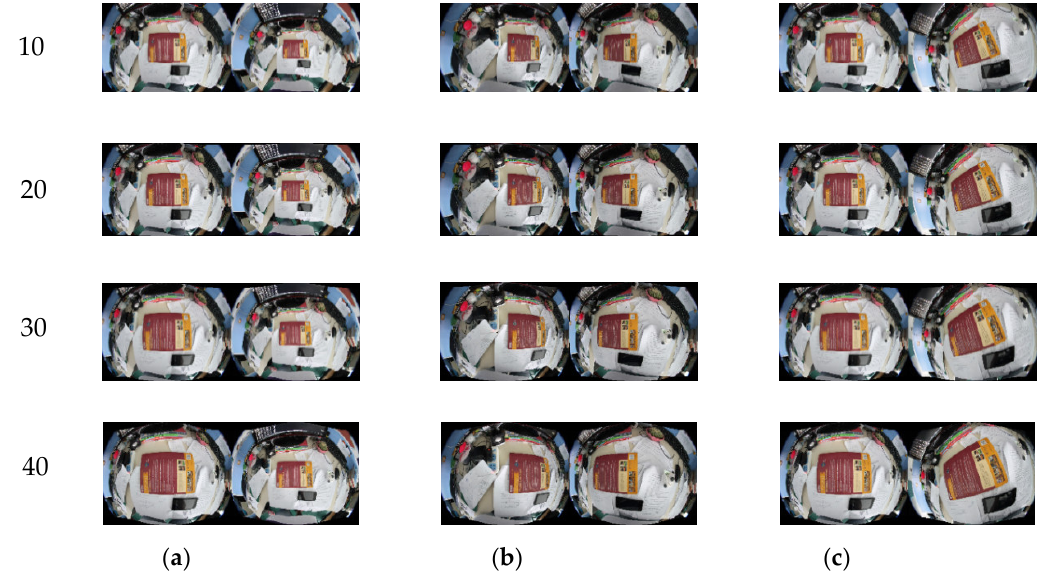
Figure 9. Image pairs used in the experiment: the numbers in the left column are degree of distortion percentages; ( a ) shows the scaled image pairs; ( b ) shows the translated image pairs; ( c ) shows the affined image pairs.